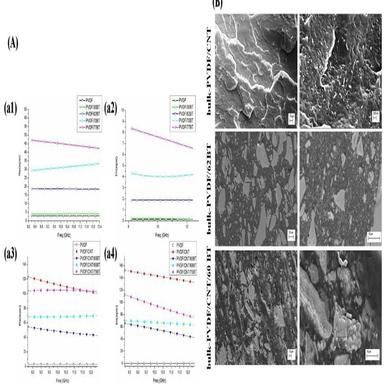
(A) ε′(a1) and ε″(a2) values vs frequency for bulk PVDF and PVDF/xBT systems at different BT contents; ε′(a3) and ε″(a4) values vs frequency for bulk PVDF, PVDF/CNT and PVDF/CNT/xBT systems; (B) SEM micrographs of bulk-PVDF/CNT, bulk-PVDF/62BT and bulk-PVDF/CNT/60BT systems prepared by film staking films of the same composition.